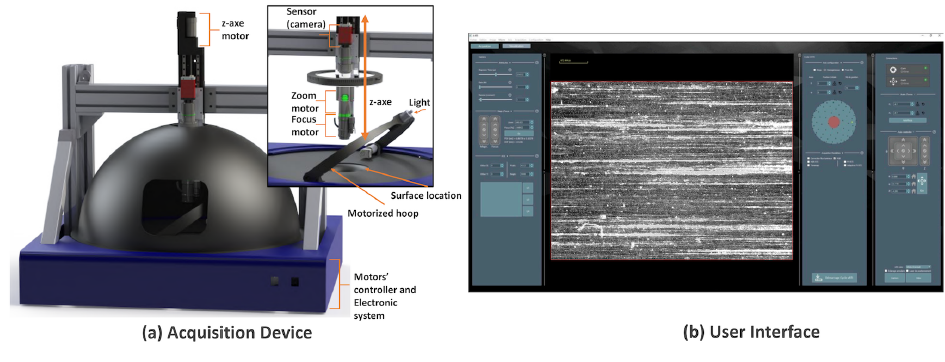
Figure 3. ( a ) Custom RTI acquisition system (ImViA Laboratory). ( b ) The associated user